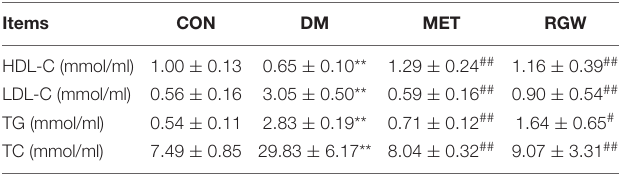
TABLE 3 | Serum biochemical parameters of rats in different groups after being treated for 21 days ( n = 8). Items CON DM MET RGW